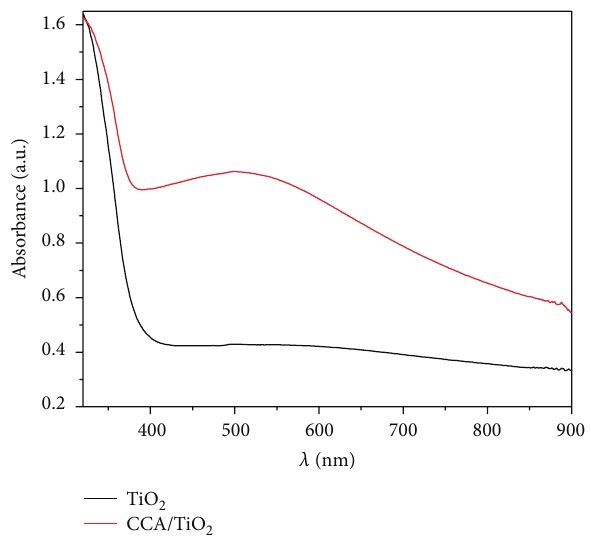
Figure 3: UV-Vis diffuse spectra of TiO 2 and CCA/TiO 2 nanocata- lysts.